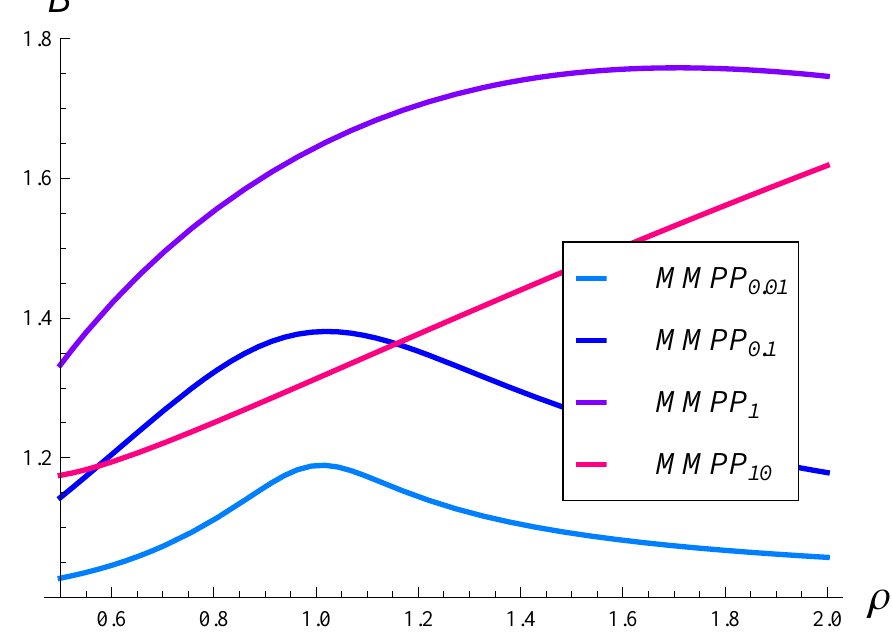
Figure 6. Burst ratio vs. the link load for arrival processes with different autocorrelations. Quadratic drop probabilities, i.e., r =